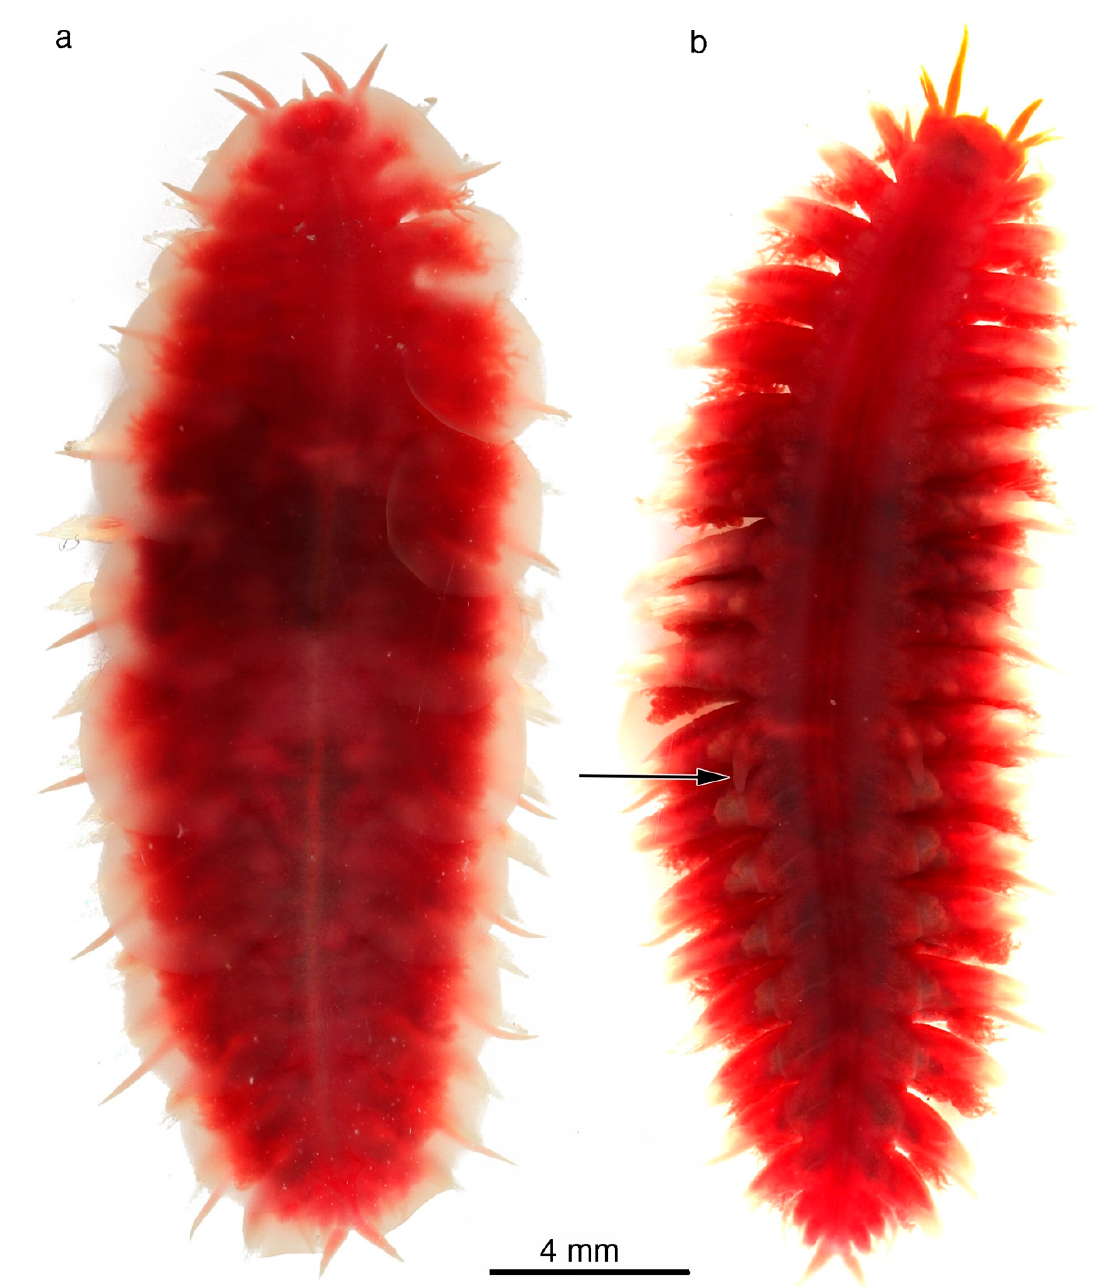
Figure 13. Branchipolynoe kajsae n. sp. live male paratype (SIO-BIC A6703). ( a ) Dorsal view. ( b ) Ventral view. Arrow indicates elongated ventral papilla of Segment 12.